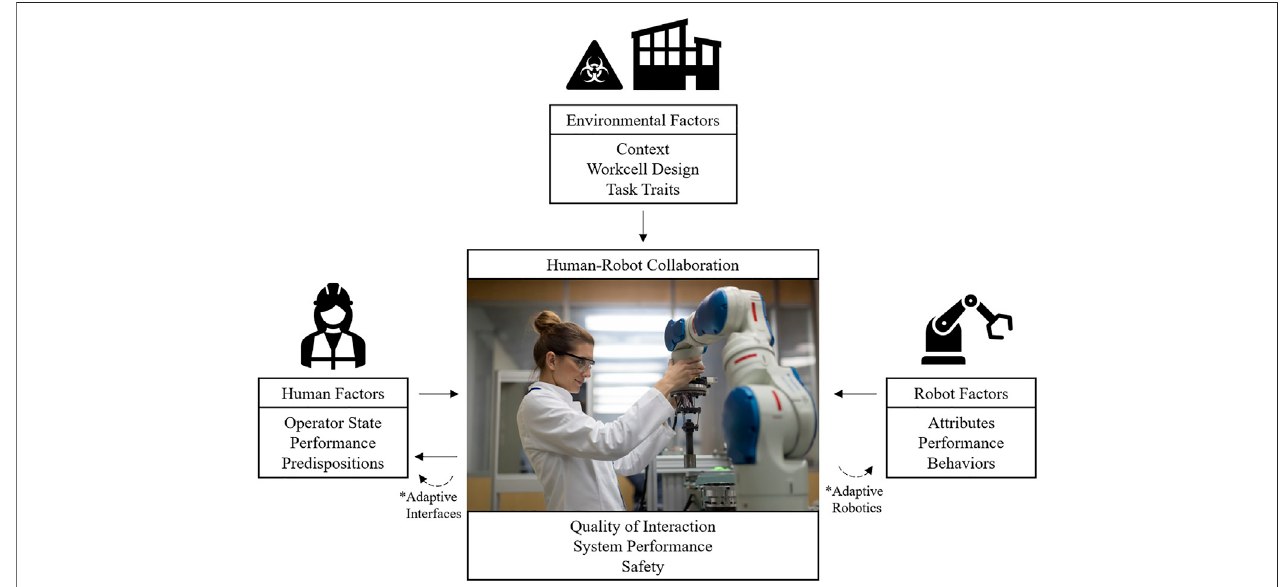
FIGURE 3 | Directional effect of factors in HRC as identi fi ed in literature review. Note. Listed subfactors are examples rather than an exhaustive list.